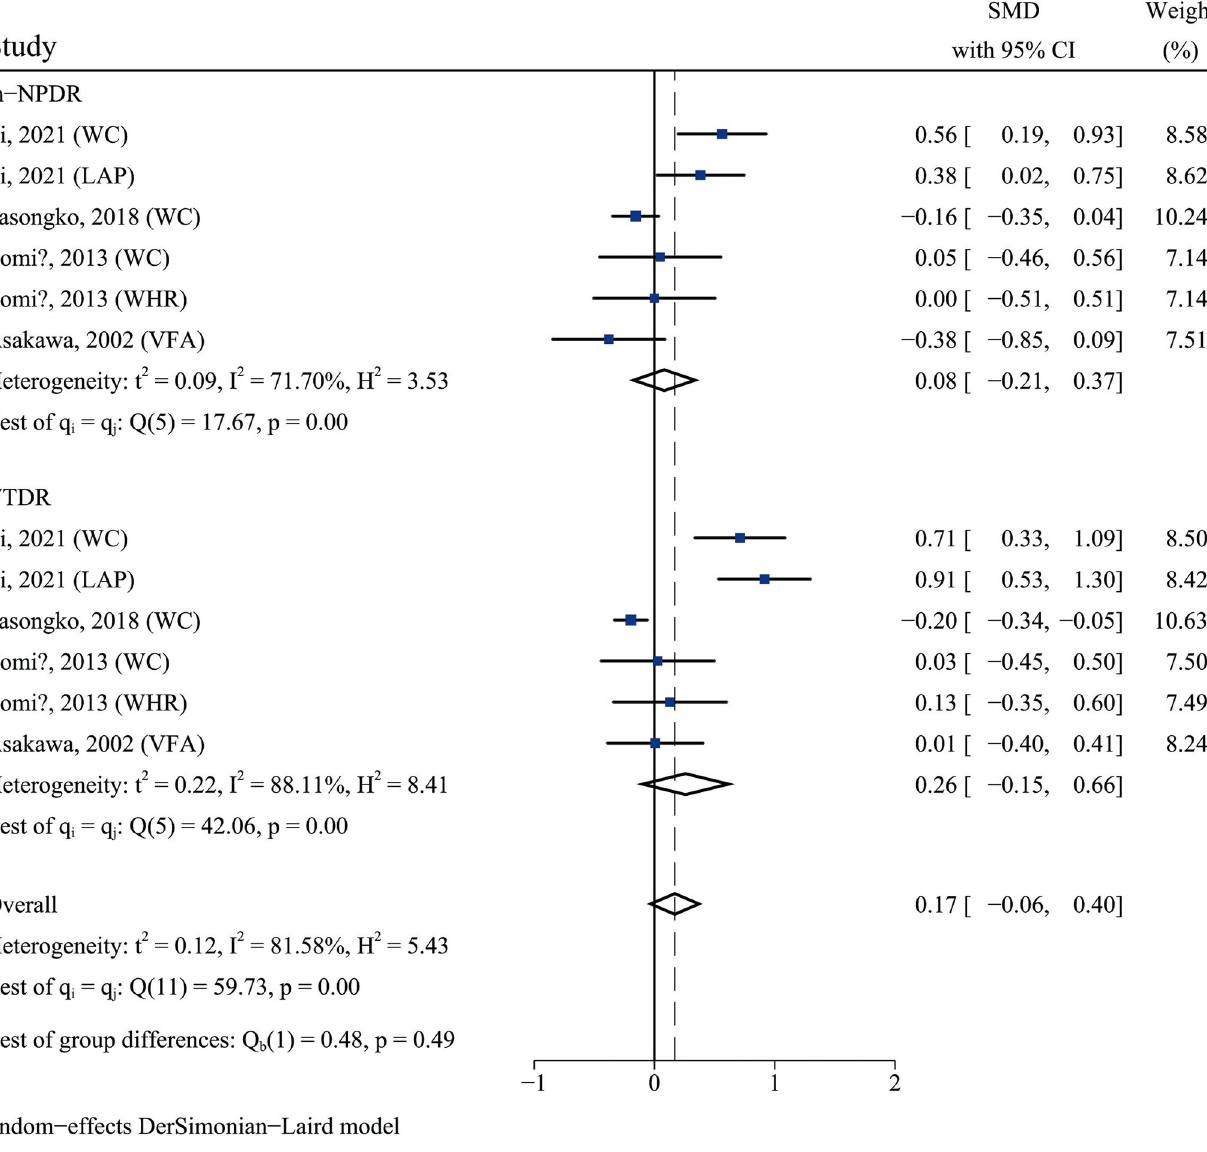
Fig 5. Forest plot of the association between abdominal obesity and diabetic retinopathy